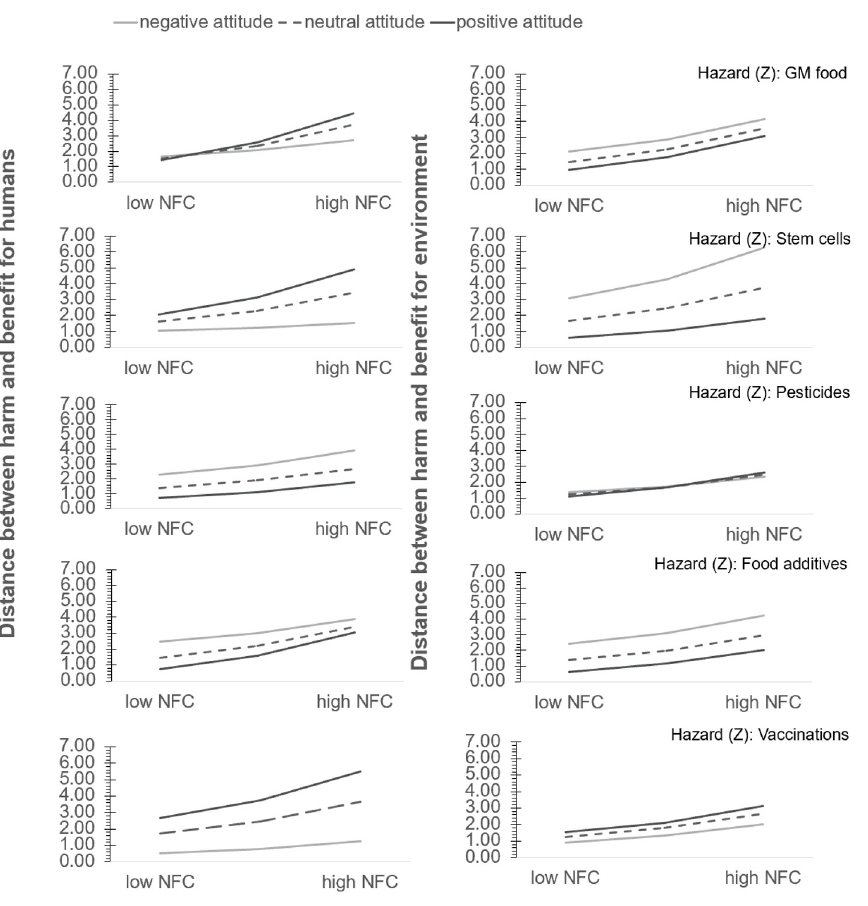
Fig 5. Moderated moderations of NFC (X) and the harm-benefit distance (Y). Left panel for humans and right panel for the environment.